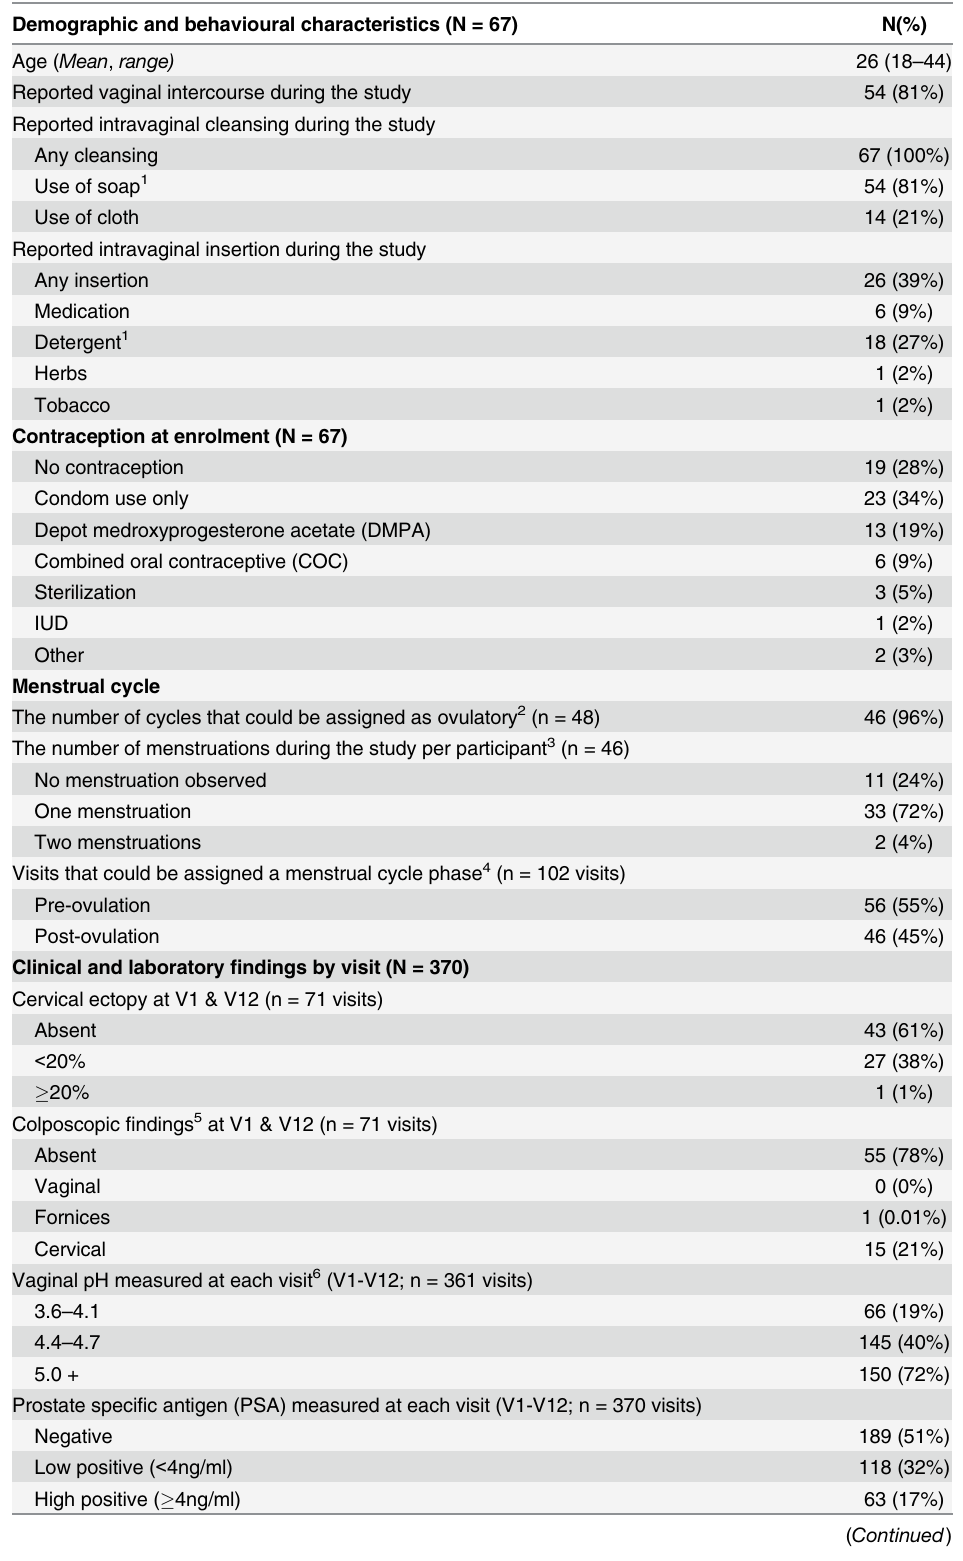
Table 1. Demographics, behaviour and clinical characteristics. Demographic and behavioural characteristics (N =